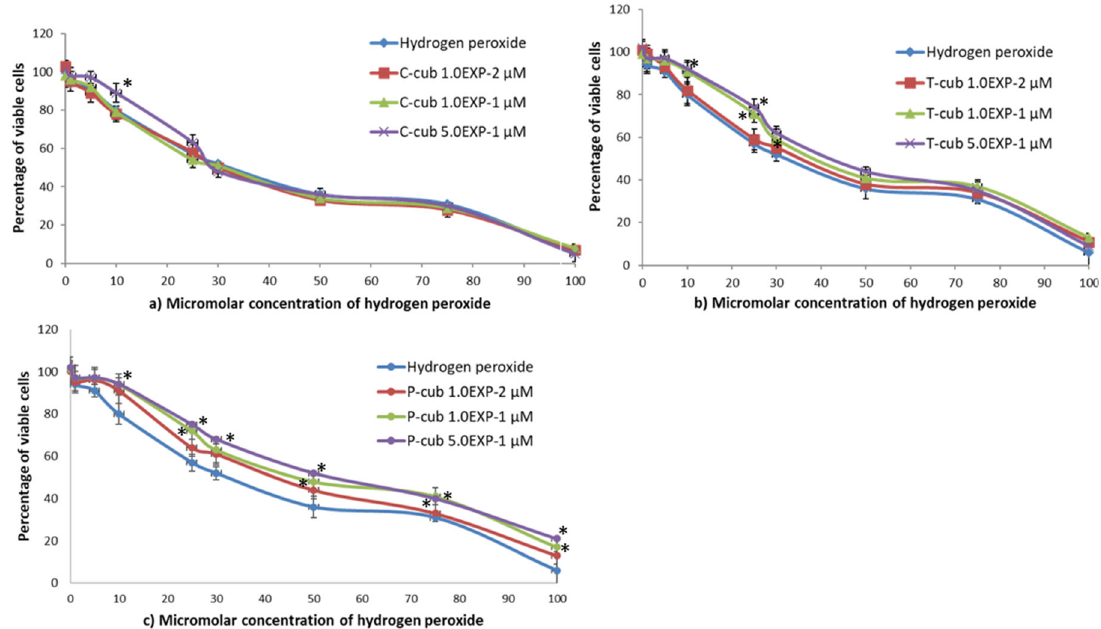
Figure 5. Antioxidant activity of ( a ) C ‐ cub, ( b ) T ‐ cub, ( c ) P ‐ cub, see Table S2 in Supplementary Materials for concentration and EE% values. * Values are statistically different versus hydrogen peroxide p < 0.05.